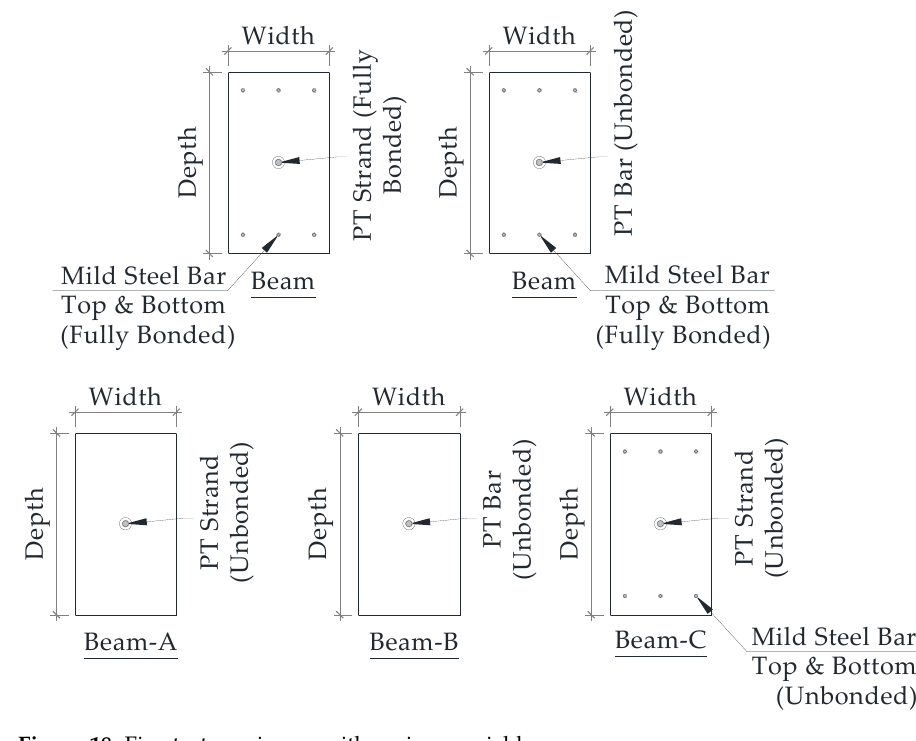
Figure 17. Precast column beam assembly with vertical dog bones.